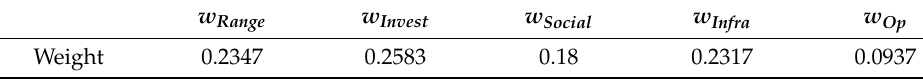
Table 2. Calculated weights (own calculations based on data from